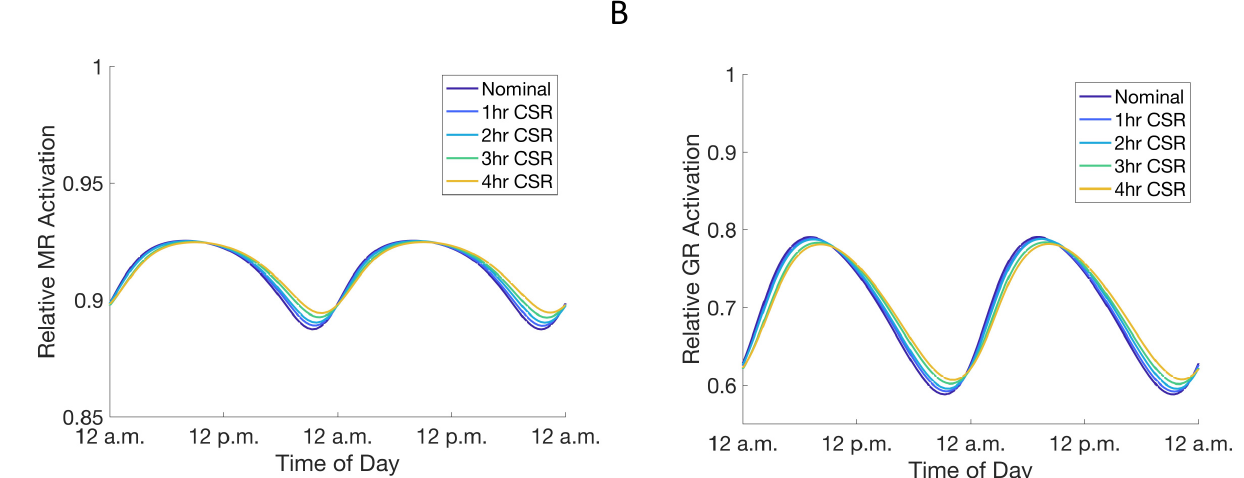
Figure 5. ( A , B ) Increase in cortisol minima is associated with a change in relative activation of GR ( B ) and MR ( A ) receptors. Colors as in Figure 4A.